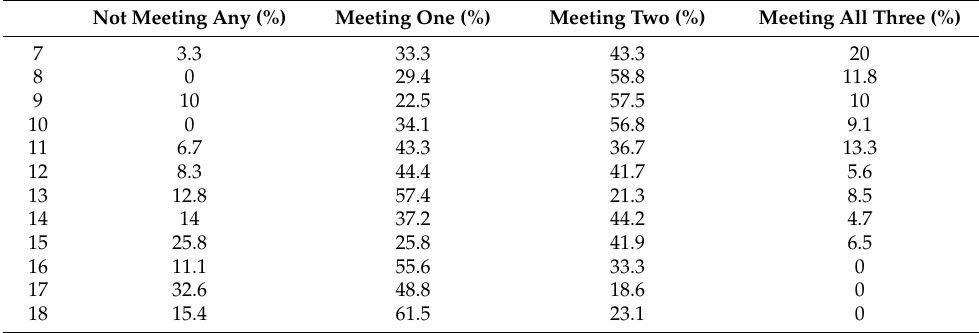
Table A1. Proportions of Chinese children and adolescents aged 7–18 meeting 0, 1, 2, or 3 of the 24-Hour Movement Guidelines.